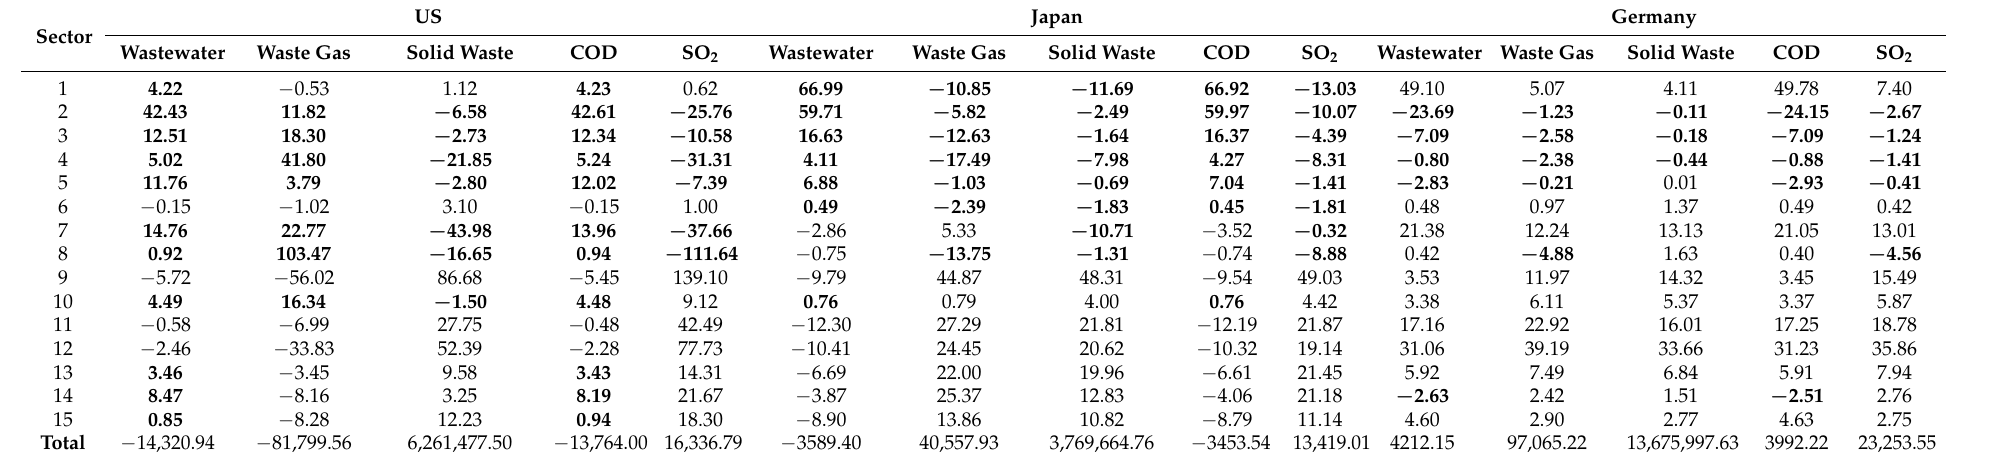
Table 1. The proportion of revised sectoral BEET between China and the US, Japan, and Germany (2016, unit for each sector: %; unit for total: tons).